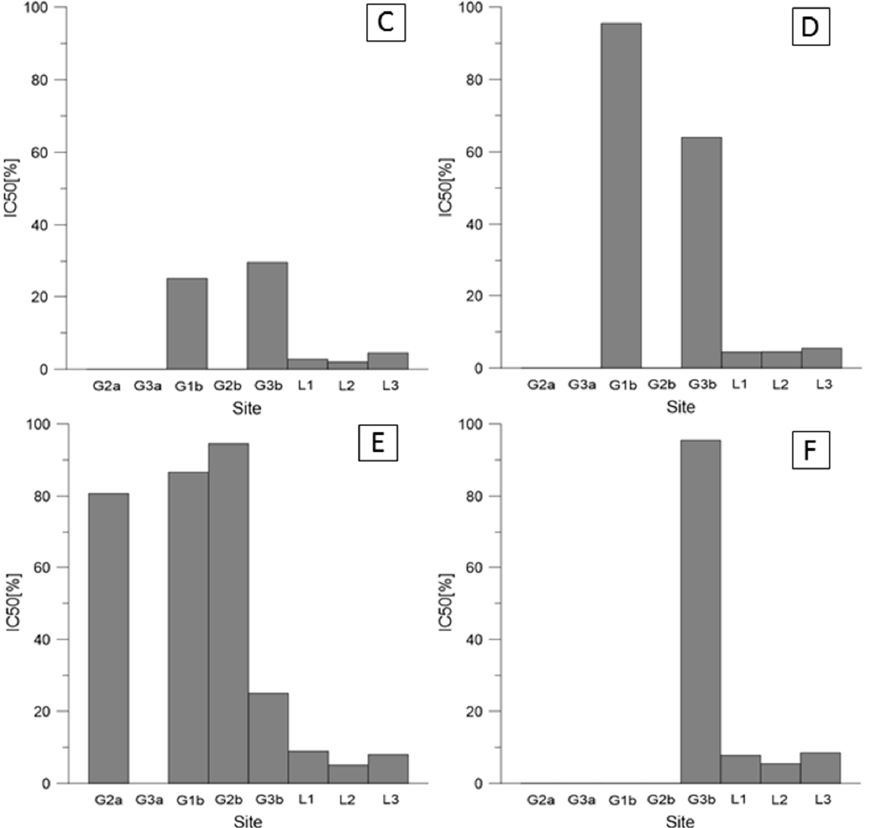
Figure 2. IC50 [%] values for soil at 100% concentration (G ł ogów and Legnica): ( A ) roots of L. luteus , ( B ) shoots of L. luteus , ( C ) roots of T. aestivum, ( D ) shoots of T. aestivum, ( E ) roots of Z. mays, and ( F ) shoots of Z. mays.